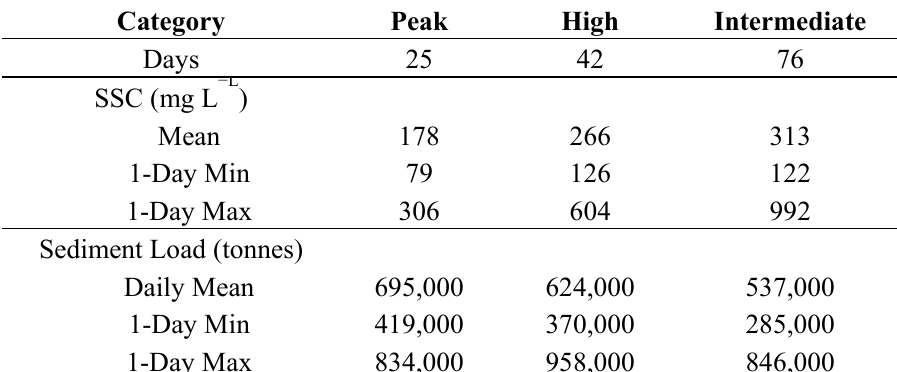
Table 3. Average duration, suspended sediment concentrations (SSC) and loads under different flow regimes from 1980 to 2010.